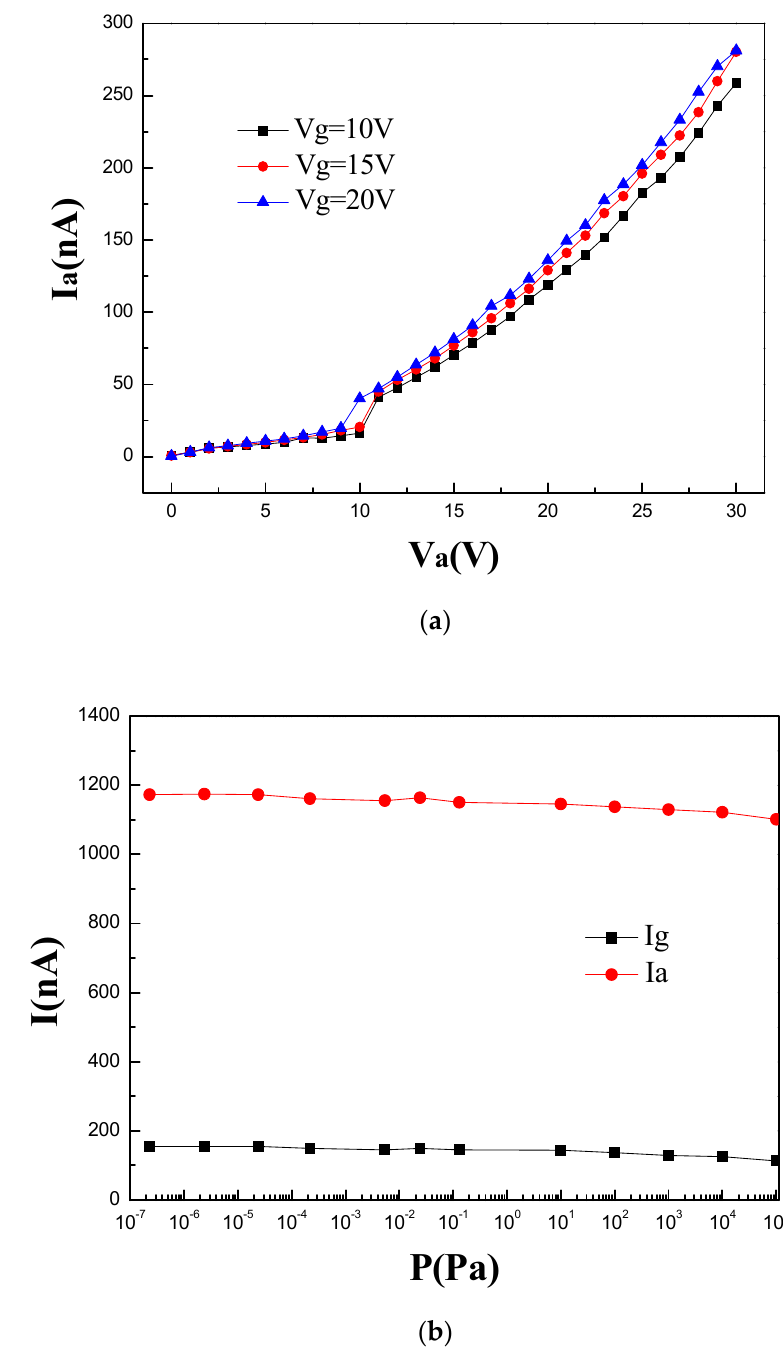
Figure 6. ( a ) Anode current versus anode voltage characteristics of a triode at V g = 10 V, 15 V, or 25 V. ( b ) Emission stability with different pressures at V g = 8 V and V a = 10 V.